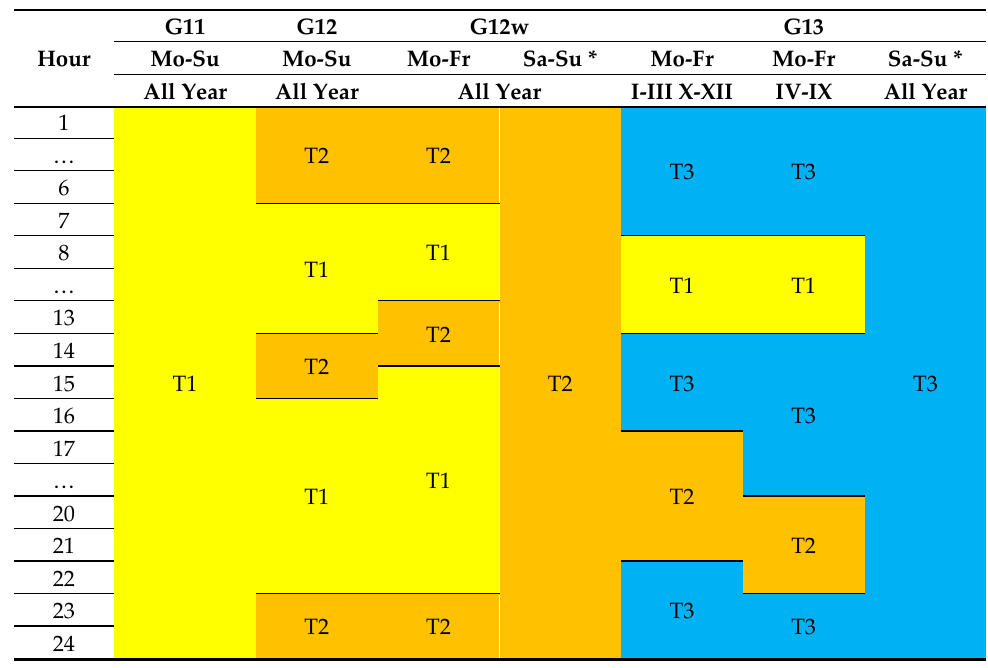
multi-zone G13 tariff. Table 1 presents time zones in G tariffs for OSD Tauron. Only for multi-zone tariffs may it be profitable to recharge batteries not solely with solar energy. Table 1. Time zones T1, T2, T3 in G tariffs for OSD Tauron. Table 1. Time zones T1, T2, T3 in G tariffs for OSD Tauron.